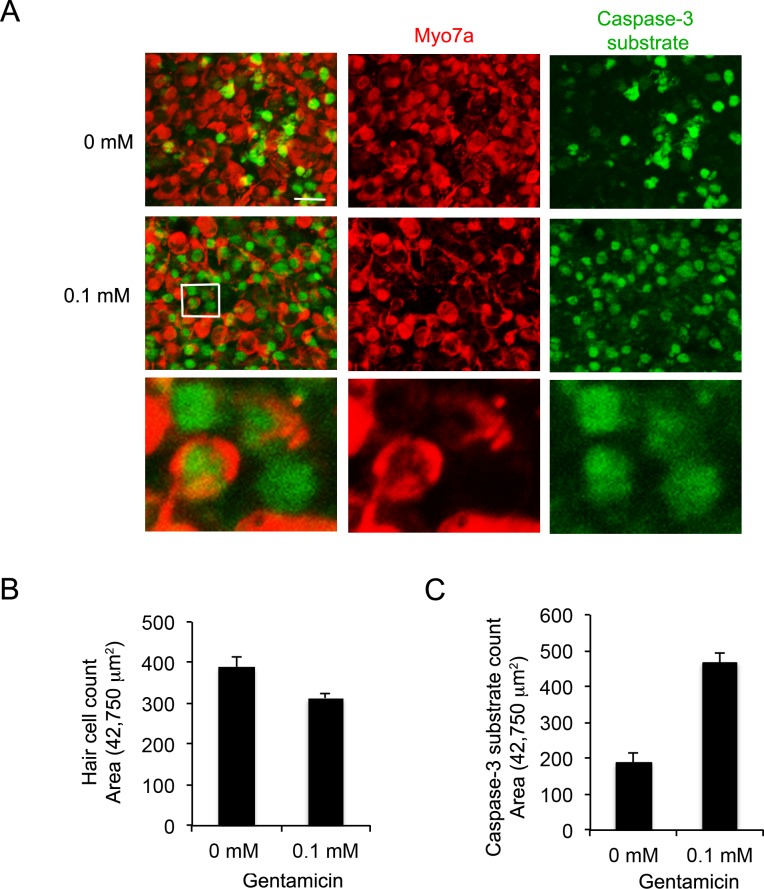
Characterization of cell death in utricle explants acutely treated with gentamicin.(A) Myo7a staining (red) in utricle explants treated with 0.1 mM gentamicin for 24 hr and cultured for a further 24 hr. Apoptotic cells are revealed by incubation with the NucView488 caspase-3 substrate (Cen et al., 2008). (B) The onset of hair cell death can be seen after 24 hr by a reduction in the number of Myo7a + cells, and C) an increase in the number of cells expressing active Caspase-3.